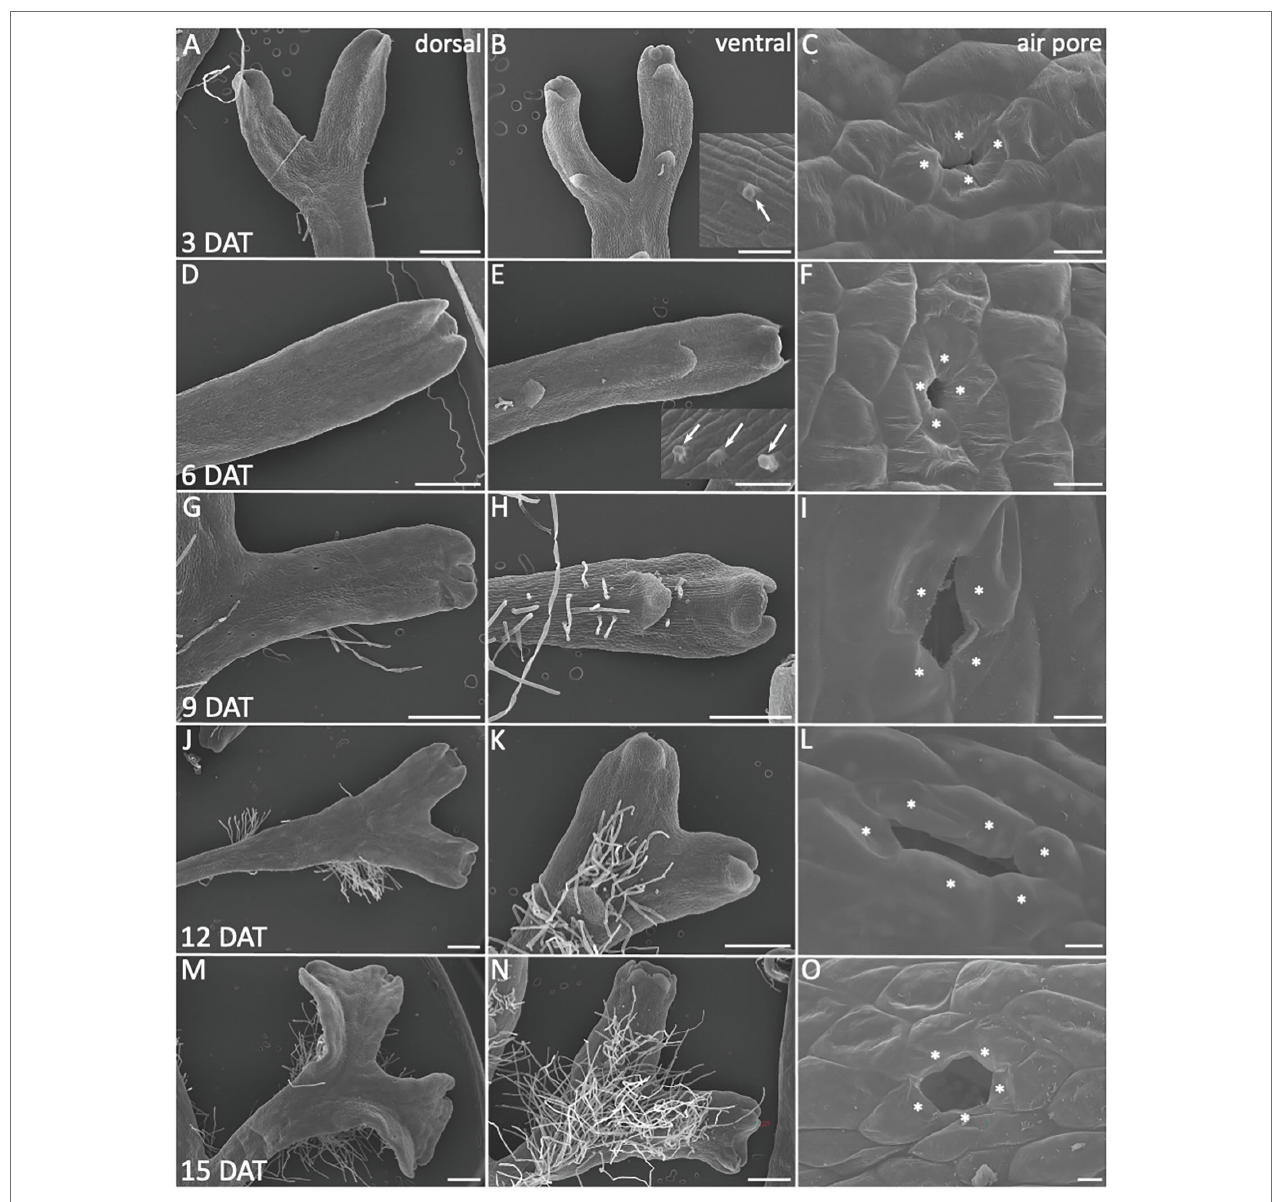
FIGURE 2 | Morphological adaptations during R. fluitans WF to LF transition. WF thalli were transferred to solid medium and investigated for morphological changes 3, 6, 9, 12, and 15 days after transfer (DAT). Left column shows dorsal, middle column ventral thallus sides, the latter revealing scale and rhizoid formation. Air pore structures are shown in the right column. (A – C) 3 DAT. Arrow in inset (B) points to outgrowth from a rhizoid initial cell. (C) WF air pore with small opening, likely by collapse of formerly invagination covering protrusions. (D–F) 6 DAT. Inset in (E) shows outgrowing rhizoids (arrows). (G – I) 9 DAT. (J–L) 12 DAT. (M–O) 15 DAT, a typical mature, large air pore, formed by more than the initial four pore ring cells (O) . Pore ring cells are marked by asterisks according to probable cell borders. Scale bars: 500 μ m; except for (C,F,I,L,O) : 10 μ